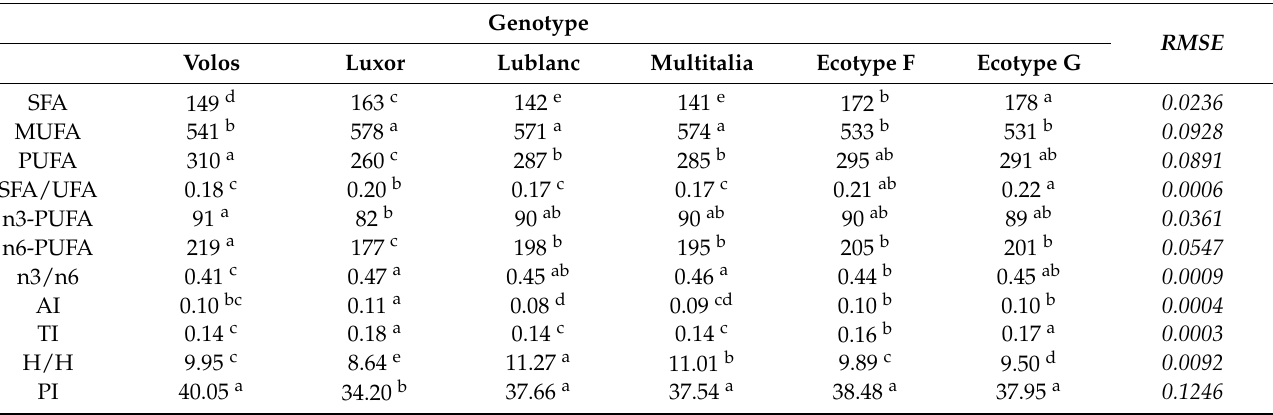
Table 4. Fatty acid classes (g kg − 1 , as fed), ratios, and quality indices in the six genotypes of Lupinus albus L. (n = 18).